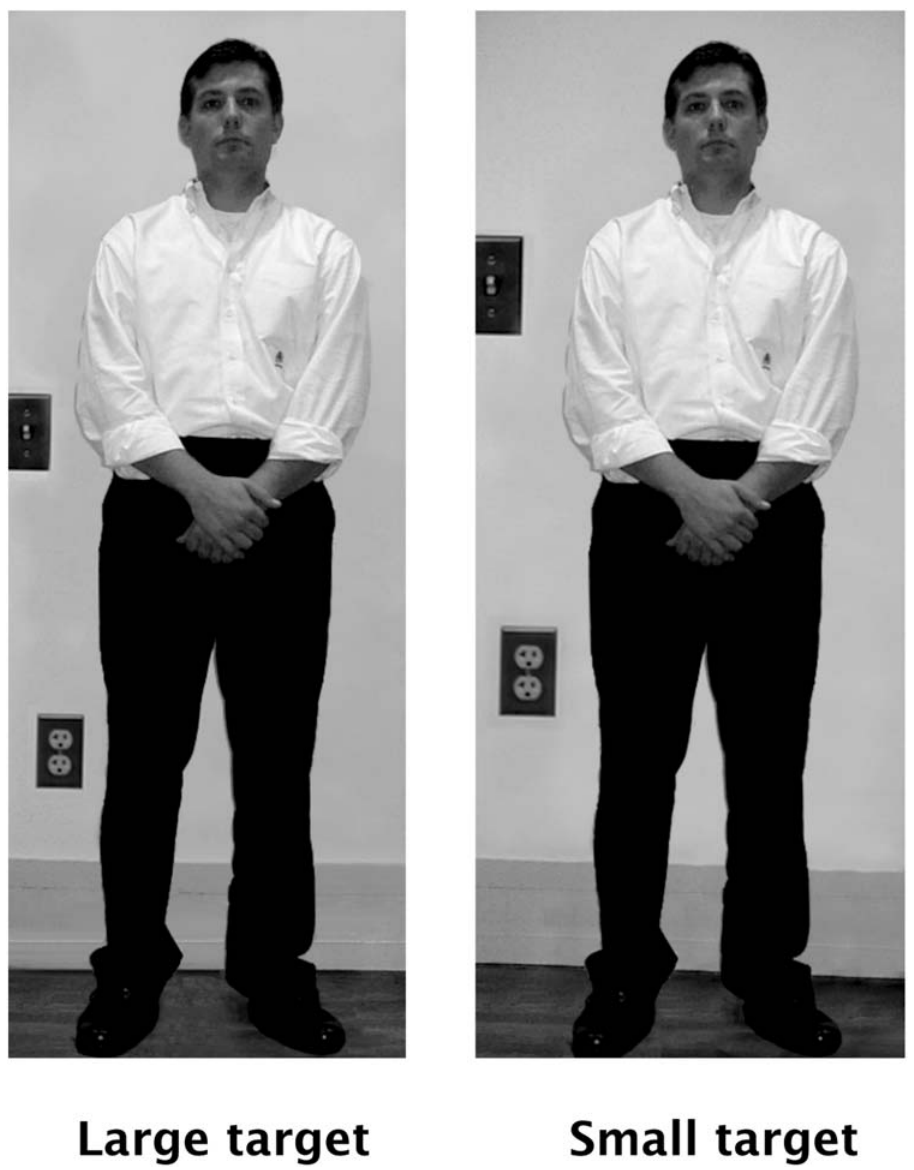
Figure 1. Example of photographs altered to influence perceived size of target.